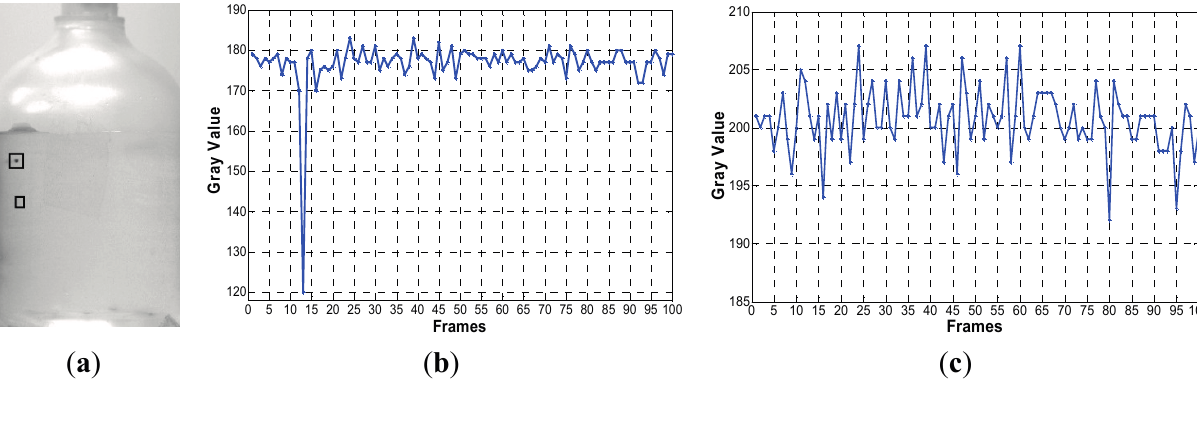
Figure 3. Variation curve of the gray value at the same position of sequential images. ( a ) A transfusion image with a black foreign matter; ( b ) The variation curve of the gray value at the position [136, 495] in 100 sequential images; ( c ) The variation curve of the gray value at the position [171, 636] in 100 sequential